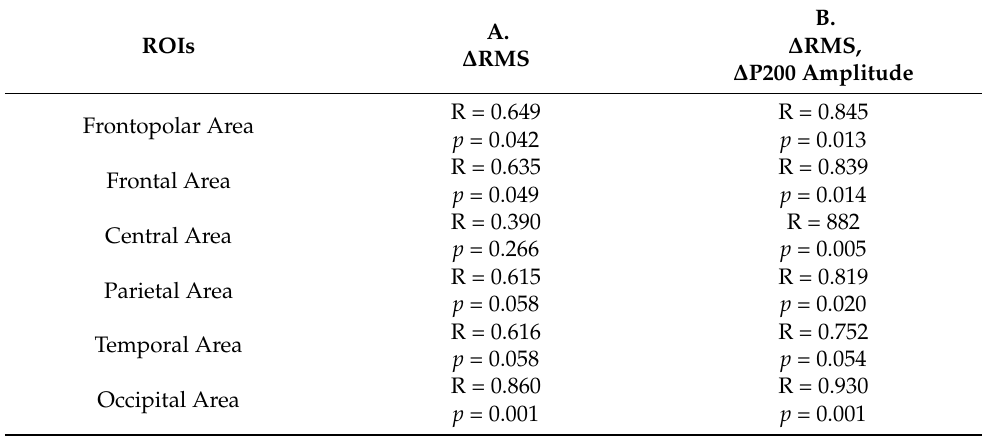
Figure 7. EEG regions of interest (ROIs) for correlational analysis between Δ RMS vs. Δ RT. The EEG electrodes were subdivided into six topographical ROIs according to their location on the scalp obtaining the frontopolar ( a ), frontal ( b ), central ( c ), parietal ( d ), temporal ( e ), and occipital ( f ) area. Within the scatter plots, circles represent single participant and the continuous lines correspond to the regression line of all the plotted points. Table 2. Pearson’s correlations between Δ RT and Δ RMS (A)/ Δ RMS and Δ P200 Amplitude (B) obtained in the six topographical ROIs.